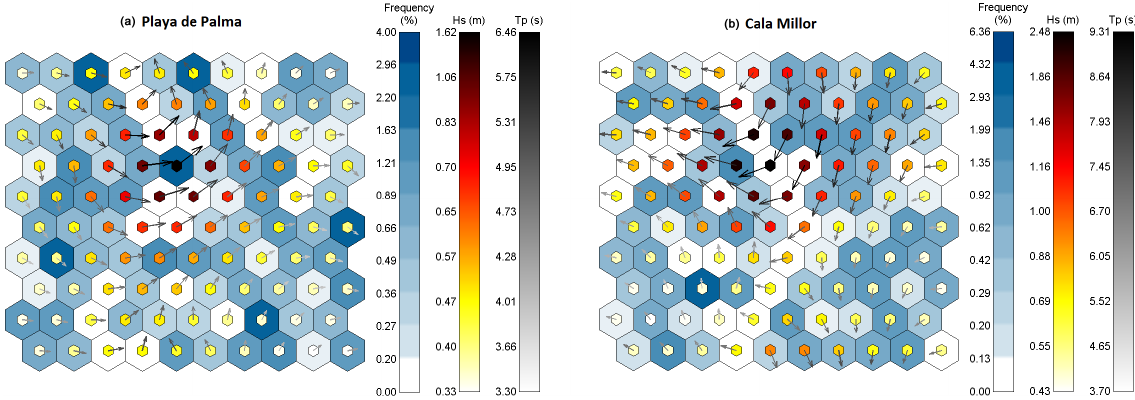
Figure 2. Playa de Palma and Cala Millor self-organizing maps (SOMs). SIMAR databases are shown in 100 cells displaying the more representative deep water sea conditions at the Playa de Palma (a) and Cala Millor (b) beaches. The blue colour illustrates the frequency of the sea states, together with the H s in metres (yellow to red), the period in seconds (white to black) and the direction in arrows. It can be seen that the more energetic conditions come from the SW in Playa de Palma and from the NE in Cala Millor, the higher frequency waves are also low-energy at both